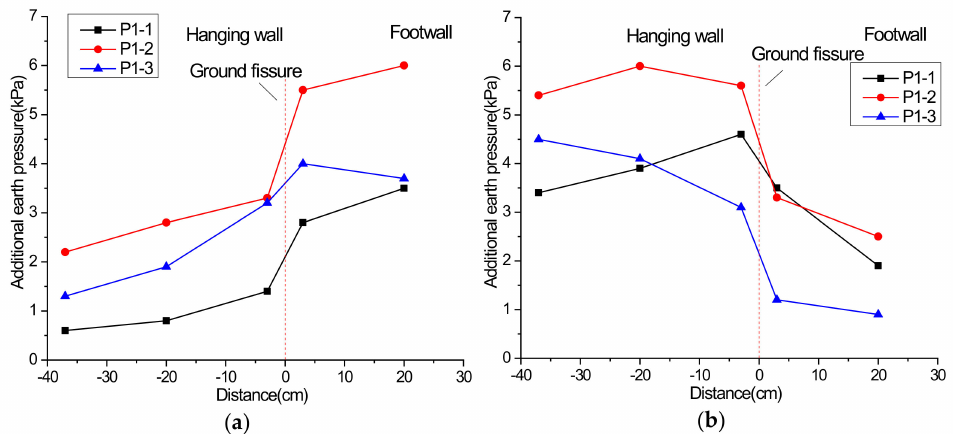
Figure 16. Additional earth pressure at 15 cm height under the scenario of inactive ground fissure: